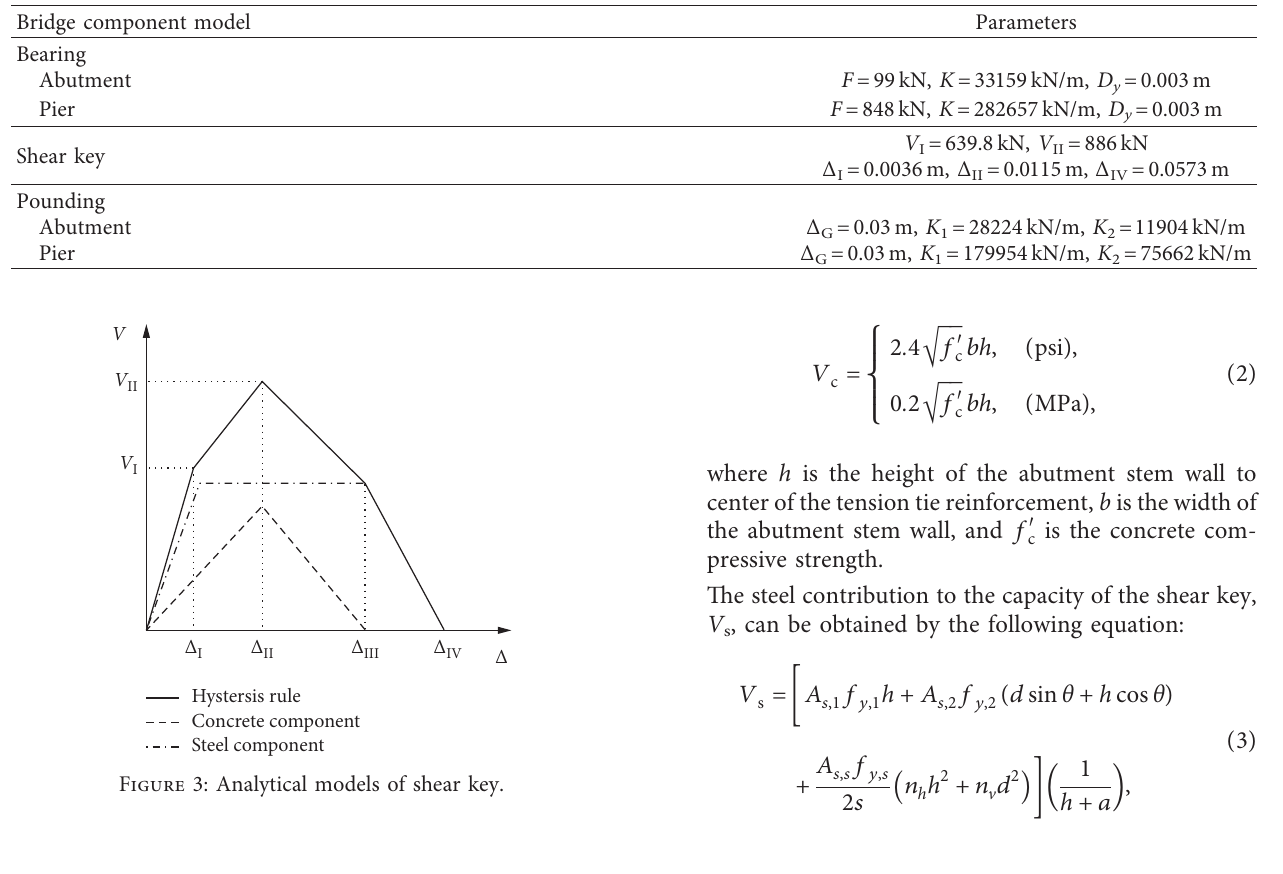
Figure 2: Finite element model of the prototype bridge. Table 1: Parameter values for various analytical models for continuous beam-arch bridge.